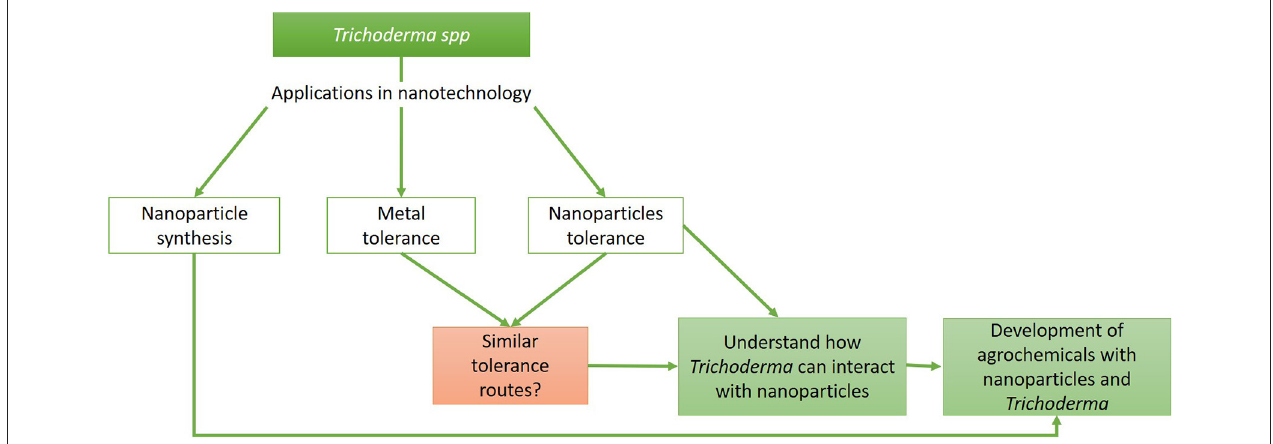
FIGURE 1 | Trichoderma and its relevance in nanotechnology. Flow chart representing the different areas where Trichoderma can be used in nanotechnology and how these can be united for the generation of products that improve agricultural crops.